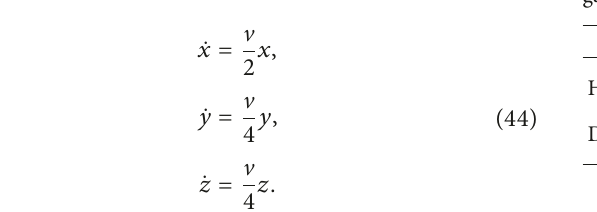
Table 2: Payoff matrix for the standard two-strategy Hawk-Dove